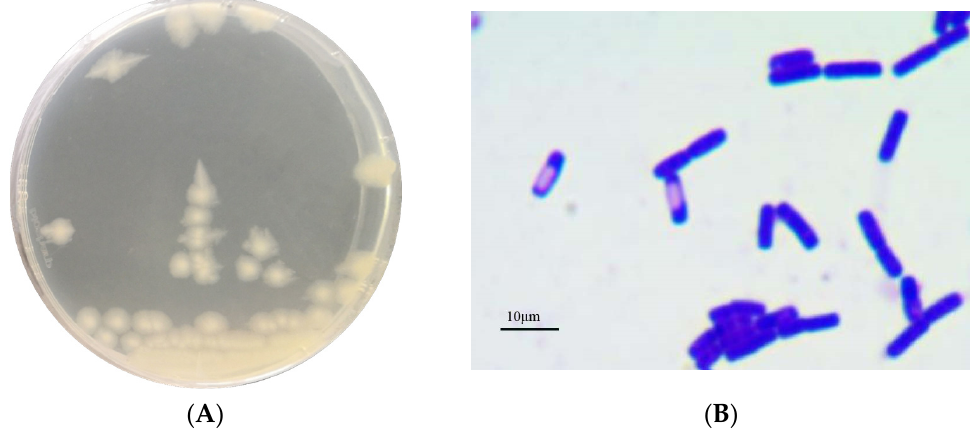
Figure 1. ( A ) Observation of colonies from strain AH7-7. ( B ) Gram staining of strain AH7-7 under the microscope (magnification 1000×, Olympus BX53).